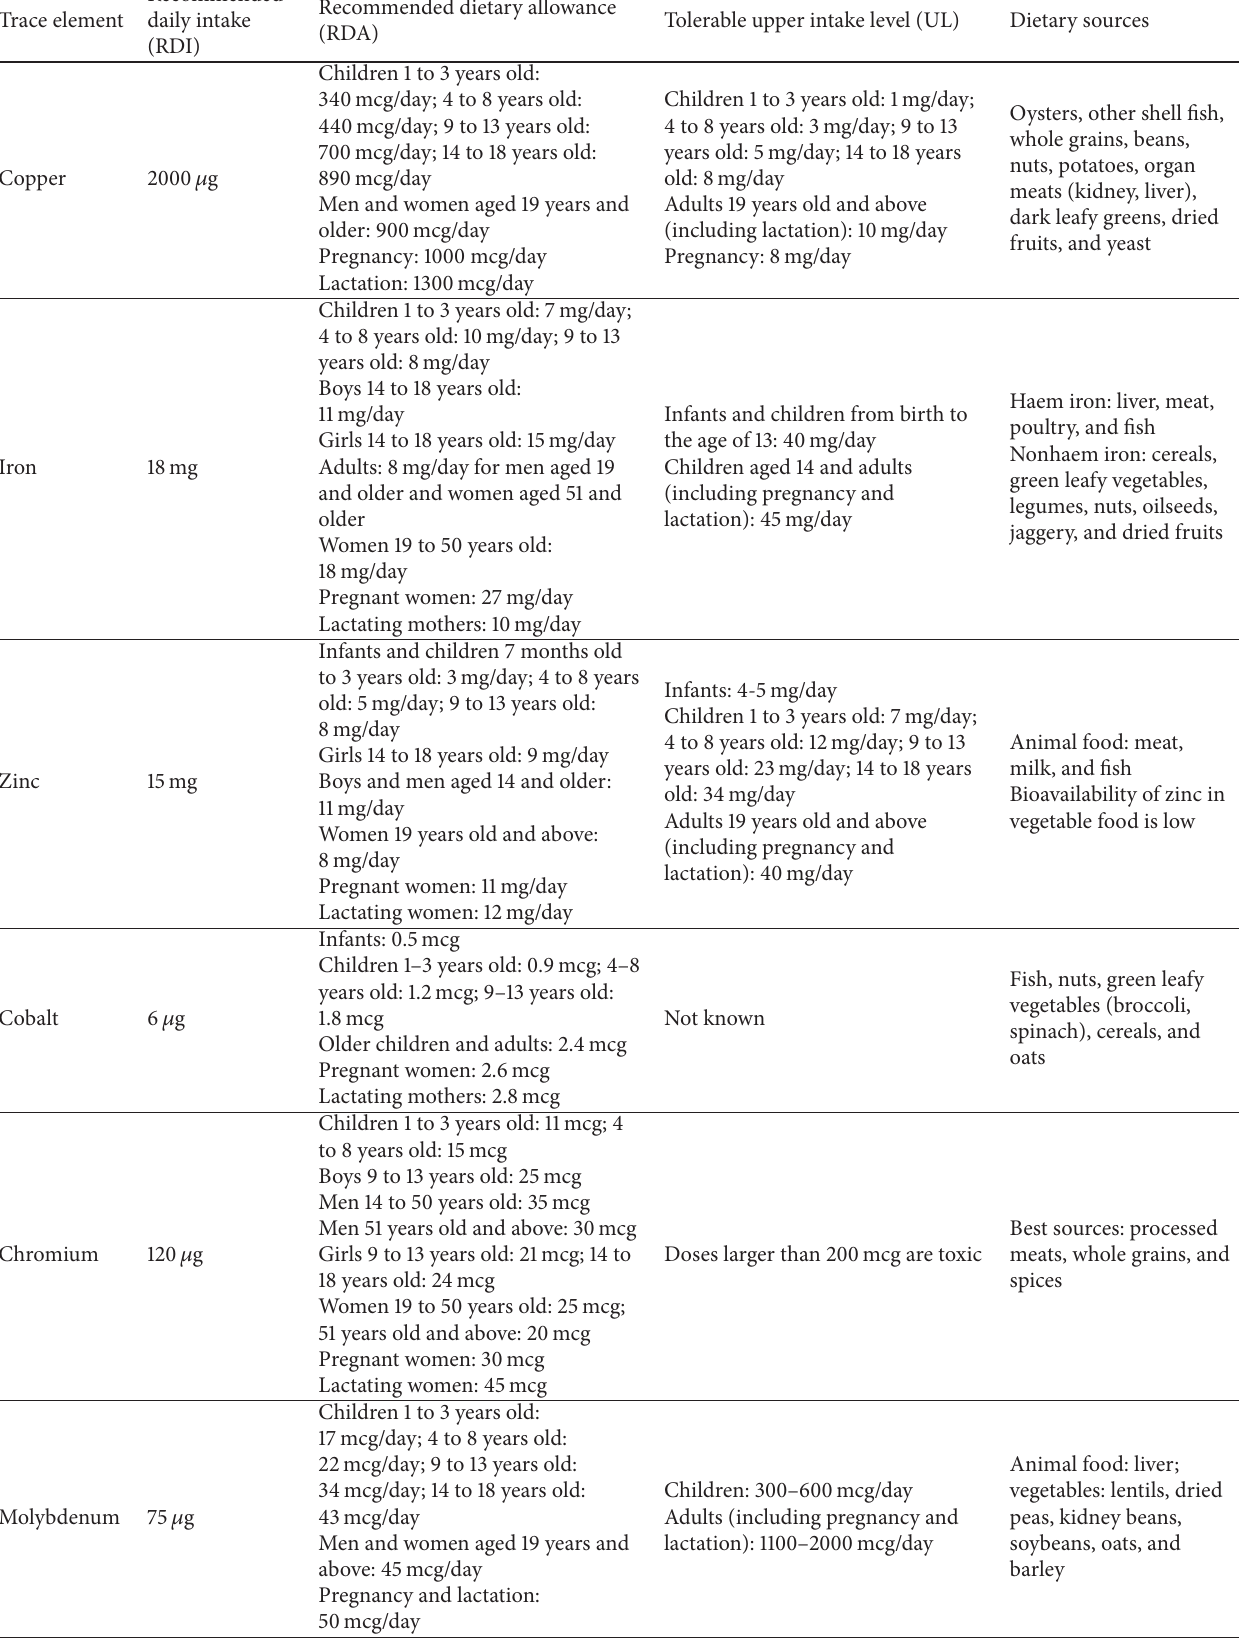
Table 1: Showing trace elements, their RDI, RDA, and UL in the body, and rich dietary sources [64, 66, 83]. Recommended Recommended dietary allowance Trace element Tolerable upper intake level (UL) Dietary